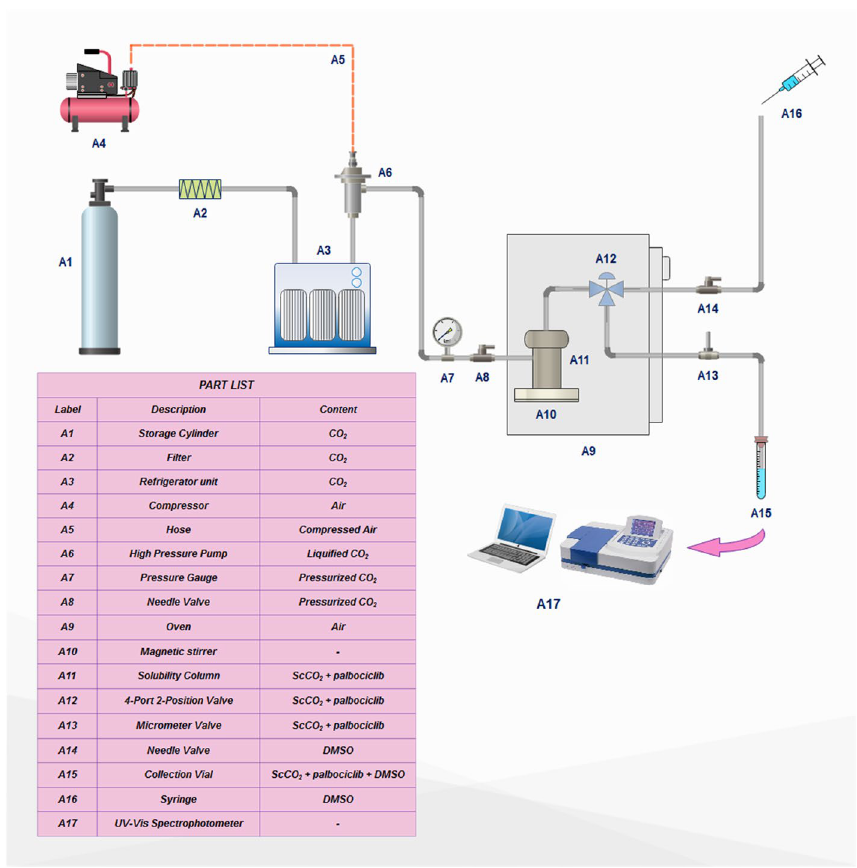
Figure 1. Experimental setup for supercritical solubility